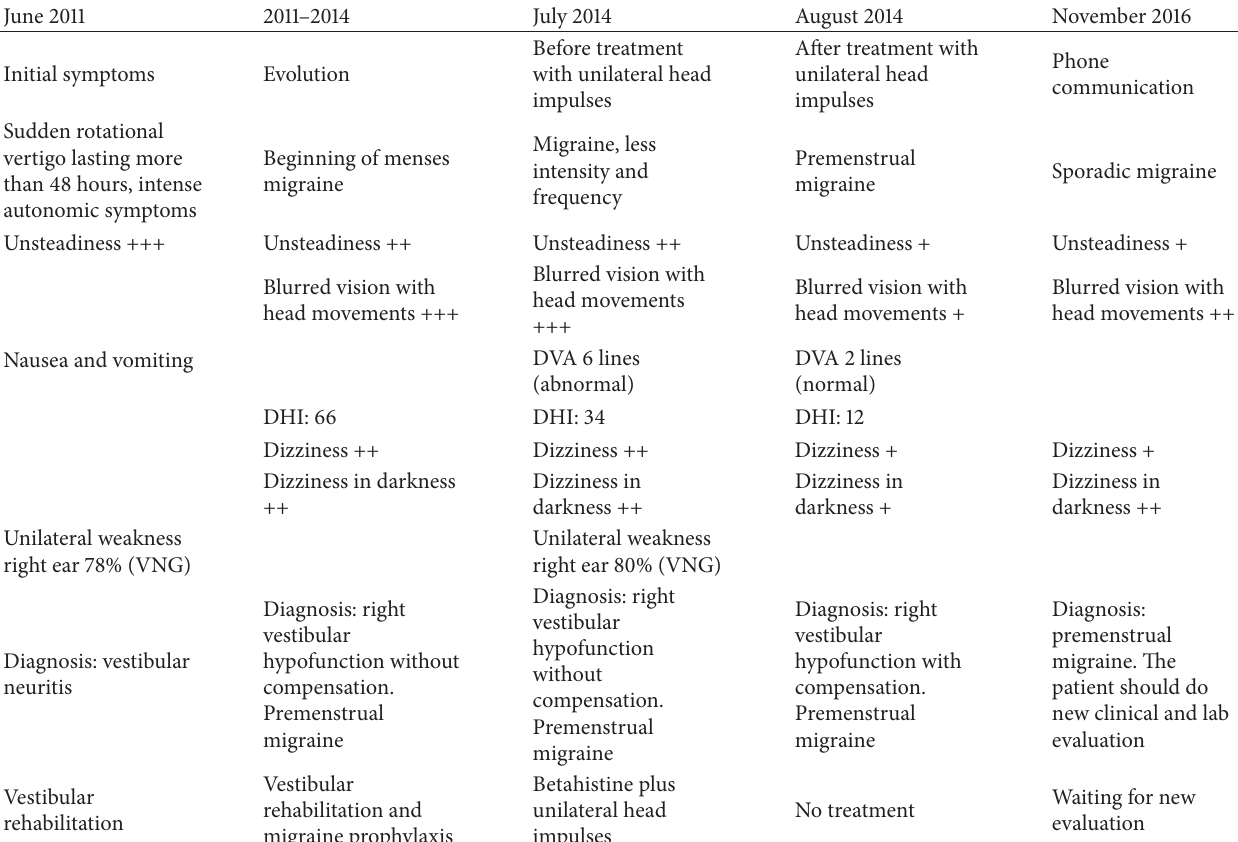
Table 1: Evolution of the symptoms, diagnosis, and